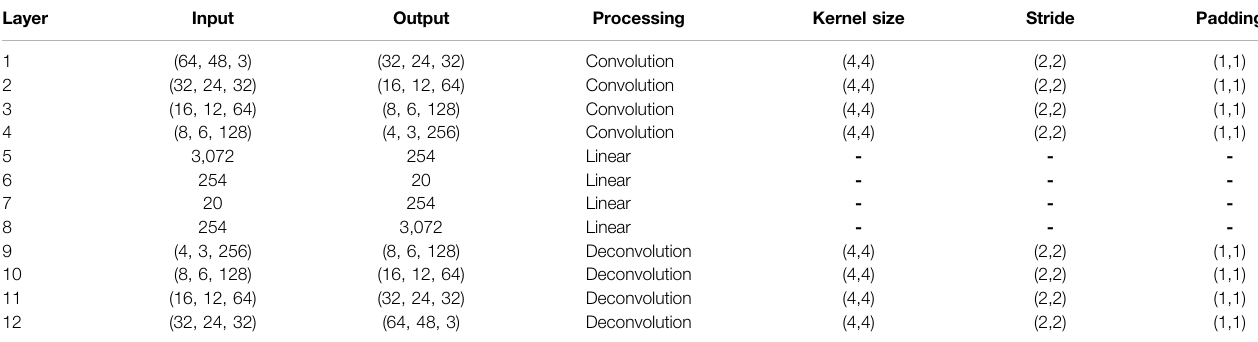
TABLE 1| TheCAE structure.Themoduleincludesconvolution layersand fullyconnectedlayers withlinearprocessing.Aninputdata passthroughthecenter layerwiththe fewest nodes, then outputs data with the original number of dimensions. Layer Input Output Processing Kernel size Stride Padding